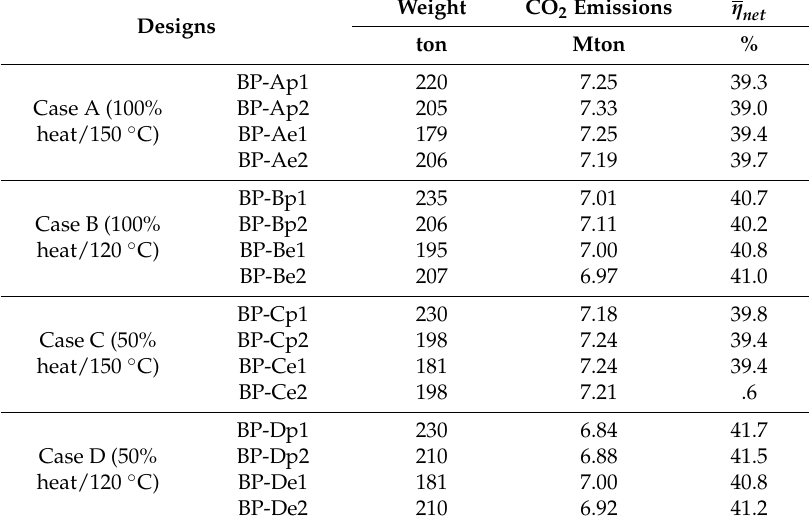
Table 5. Lifetime performance of the designs defined for the backpressure steam turbine